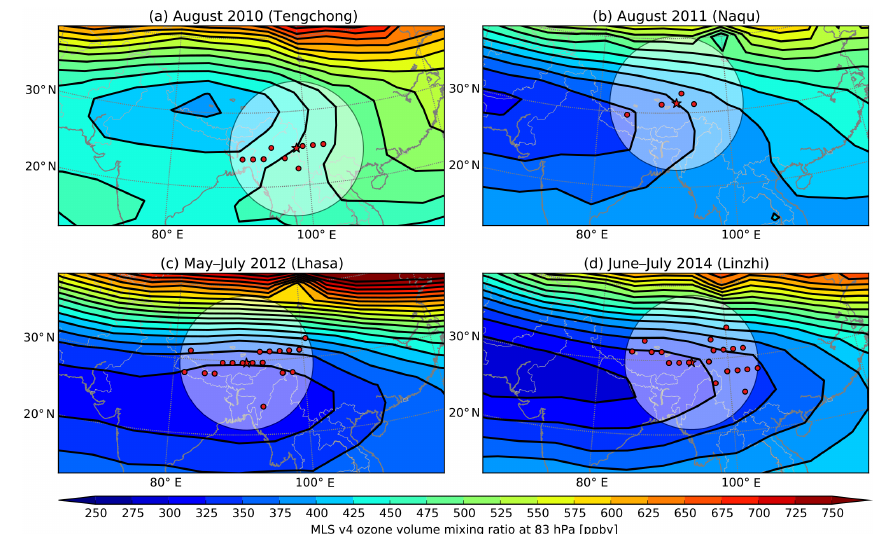
Figure 14. Balloon launch locations (red stars), centres of footprints of MLS observations collocated to balloons launched at each location (red circles) and mean spatial distributions of ozone volume mixing ratio at the 83hPa level during the measurement campaigns at (a) Teng- chong, Yunnan in August 2010, (b) Naqu, Tibet in August 2011, (c) Lhasa, Tibet in May–July 2012 and (d) Linzhi, Tibet in June–July 2014. The gridded values are inverse-distance weighted averages on a 5 ◦ longitude by 2.5 ◦ latitude grid, with weighted contributions from all valid measurements within 10 ◦ longitude and 10 ◦ latitude of the grid cell centre.